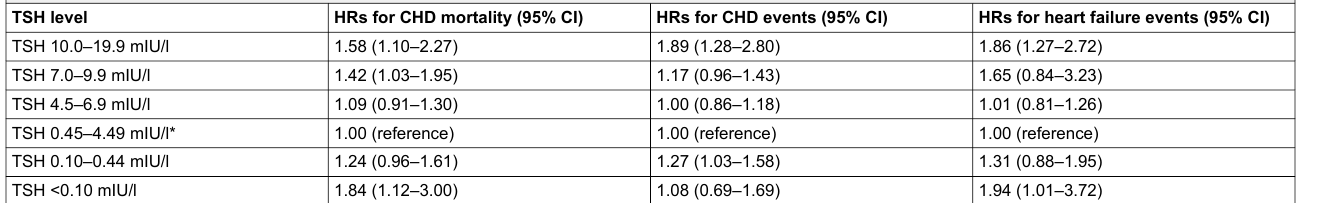
Table 2: Risk for Coronary Heart Disease (CHD) mortality and events and heart failure events according to thyroid-stimulating hormone levels. TSH level HRs for CHD mortality (95% CI) HRs for CHD events (95%